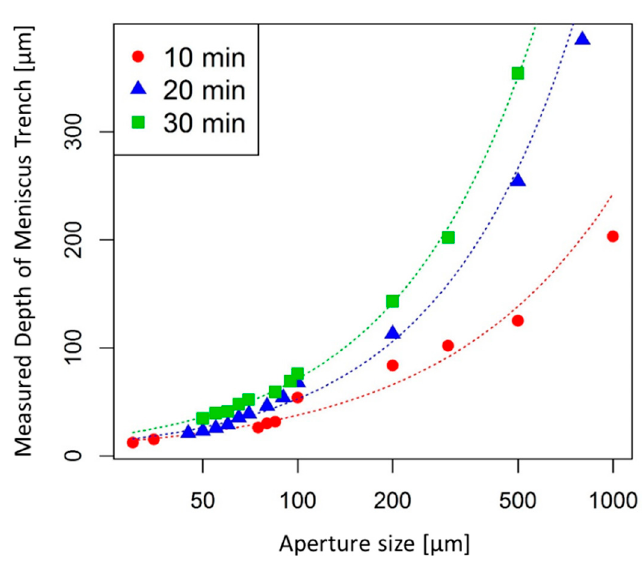
Figure 3. Relationship between the measured depth of meniscus trench for various aperture diameter at three di ff erent development time (10, 20, and 30 min).